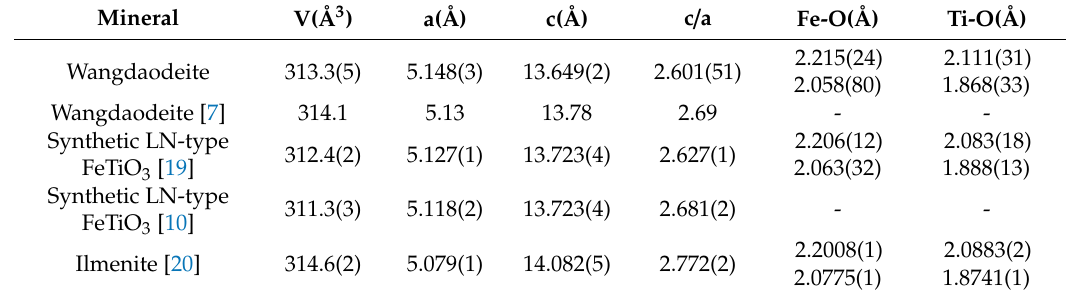
Table 2. Unit cell dimensions and interatomic distances for wangdaodeite, synthetic LiNbO 3 -type FeTiO 3 , and for